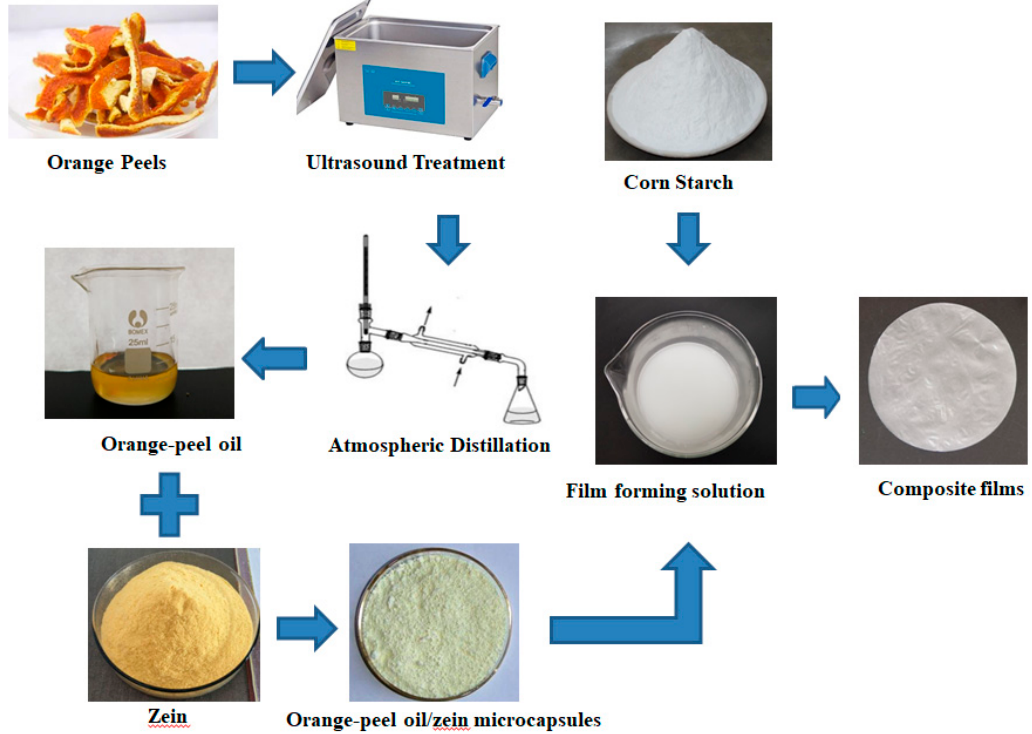
Figure 1. The schematic diagram of the steps to fabricate the corn starch (CS) / orange-peel oil (OPO) / zein nanocapsules (OZN) composite films.